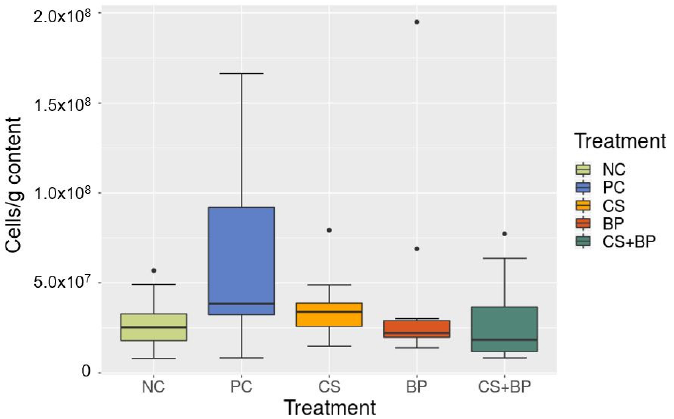
Figure 7. Comparison of the bacterial loads (in cells/g) in jejunal samples in five different groups of broilers as estimated by L. xyli spike-in controls.